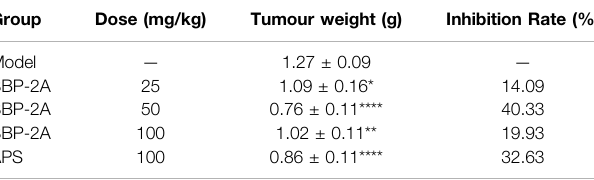
TABLE 5 | Tumour inhibition rate (%) of SBP-2A in H22 mice ( n = 6). Group Dose (mg/kg) Tumour weight